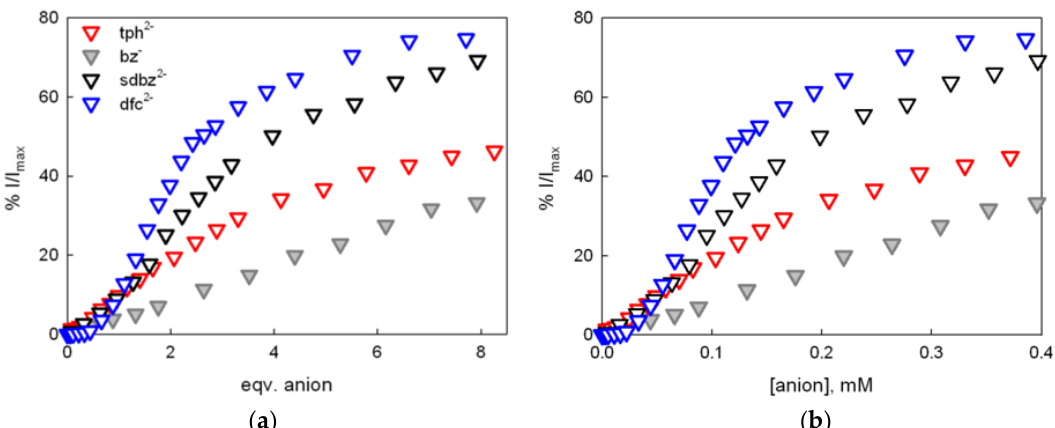
Figure 5. Competition assays with dicarboxylates (as the TBA salts, see the inset symbols) using chemosensing ensemble solutions of C (50 μ M) and I (0.25 μ M) in 1:4 H 2 O:CH 3 CN at pH 7 (0.02 M HEPES buffer); the families of profiles show the trend of I/I max vs. equivalents of the added anion ( a ) and I/I max vs. anion concentration ( b ).